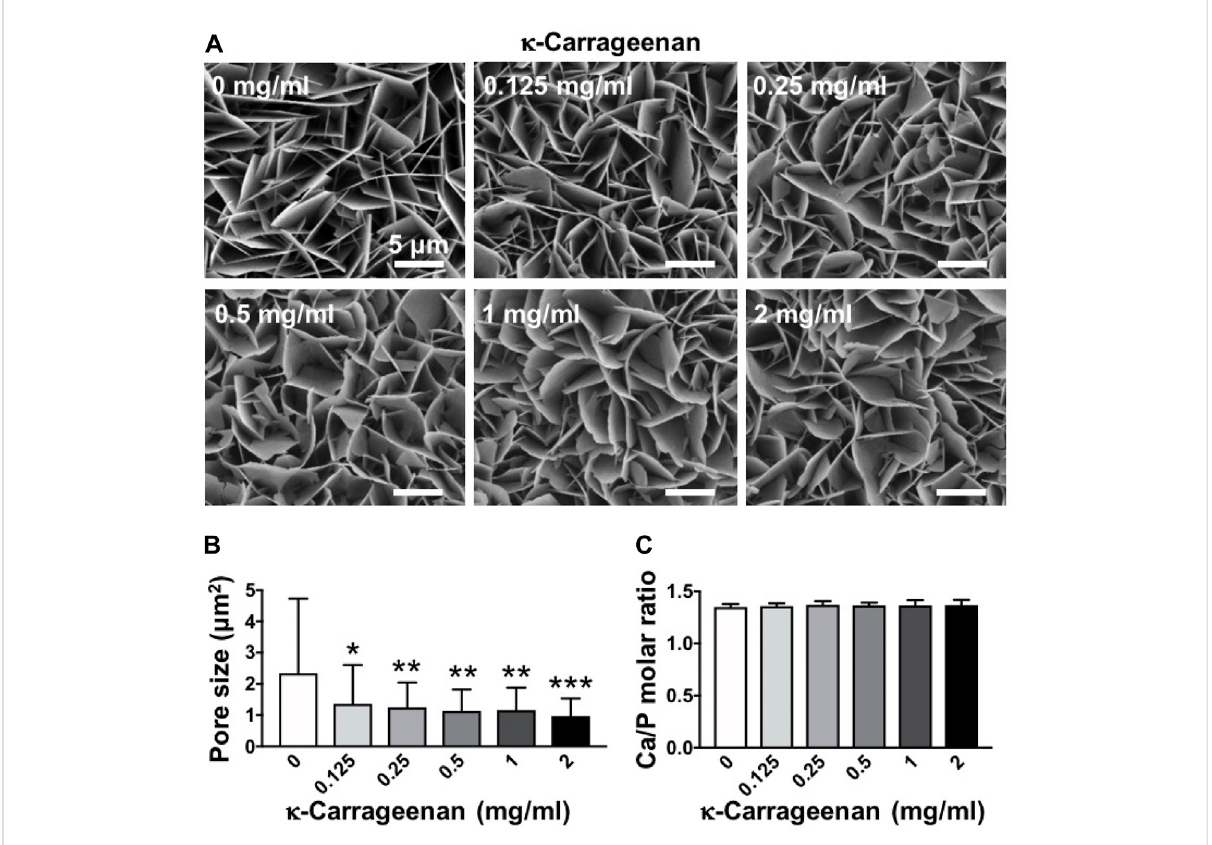
FIGURE 1 Dose-dependent effect of κ -carrageenan in octacalcium phosphate (OCP)-coating of titanium discs on surface morphology. (A) SEM micrographs. (B) Pore size. (C) Calcium/phosphate ratio. Values are mean ± SD. n = 9 from 3 independent experiments. Signi fi cant effect of κ